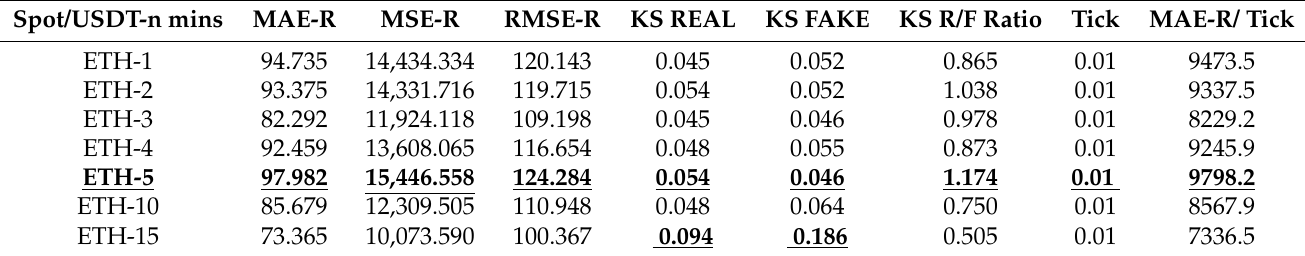
Table 10. We examined ETH spot prices against generated prices at intervals of one, two, three, four, five, ten and fifteen minutes. For KS R/F Ratio, 2 out of 7 are bigger than one, where the highest KS REAL and FAKE are 0.094 and